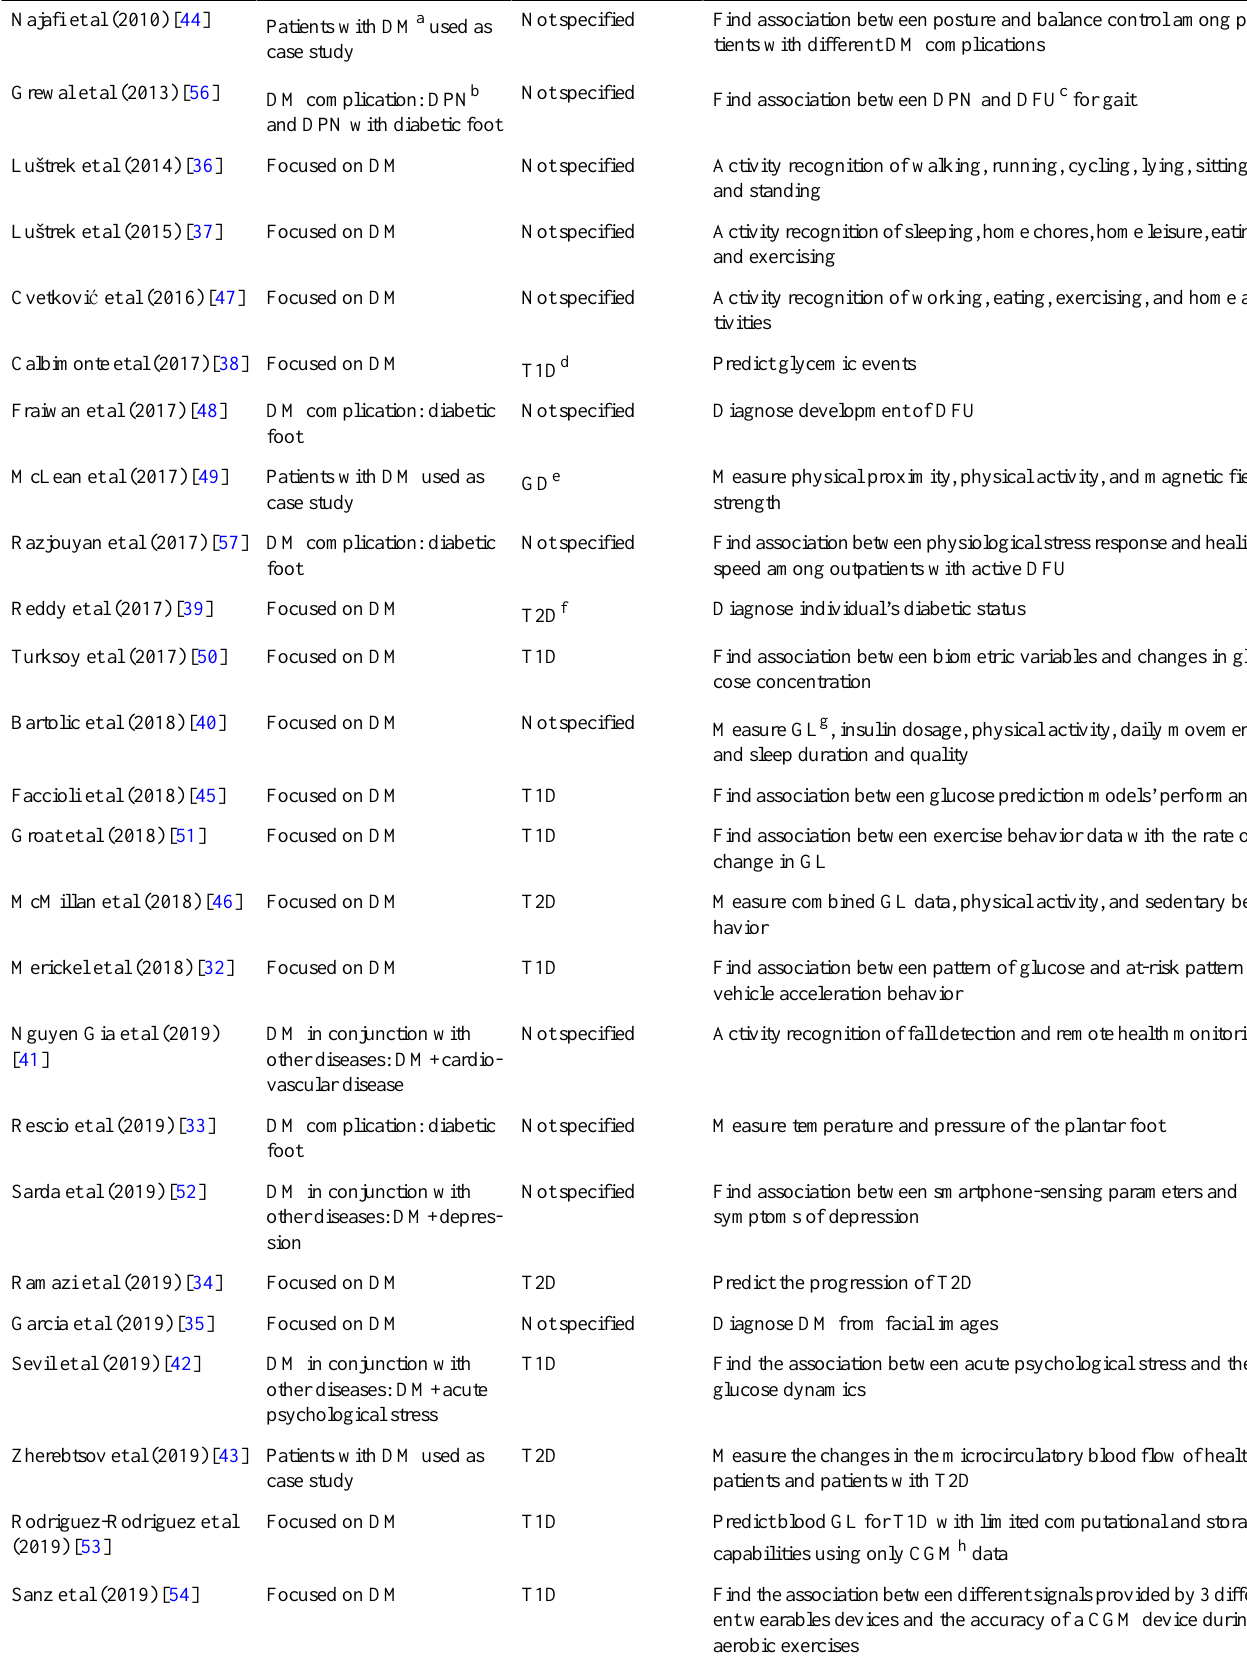
Research goalsDiabetes typeMedical